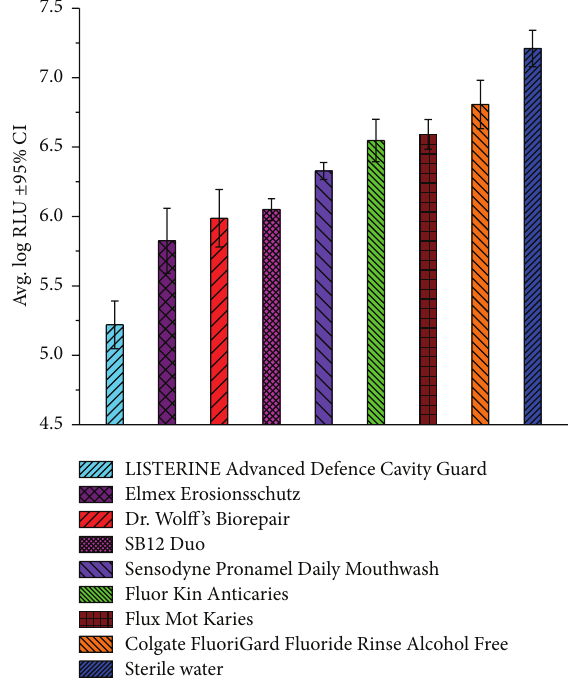
Figure 5: Mixed species flow-through biofilm assay for antimicro- bial activity.